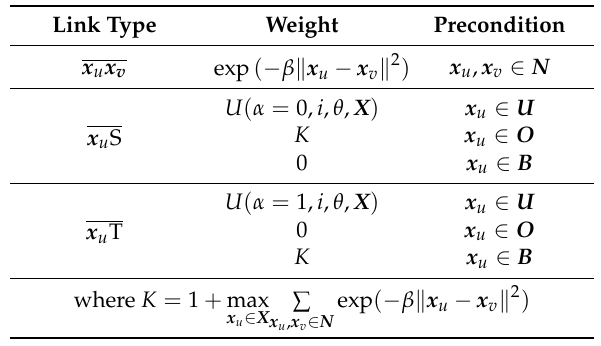
Table 1. The weight of each link.